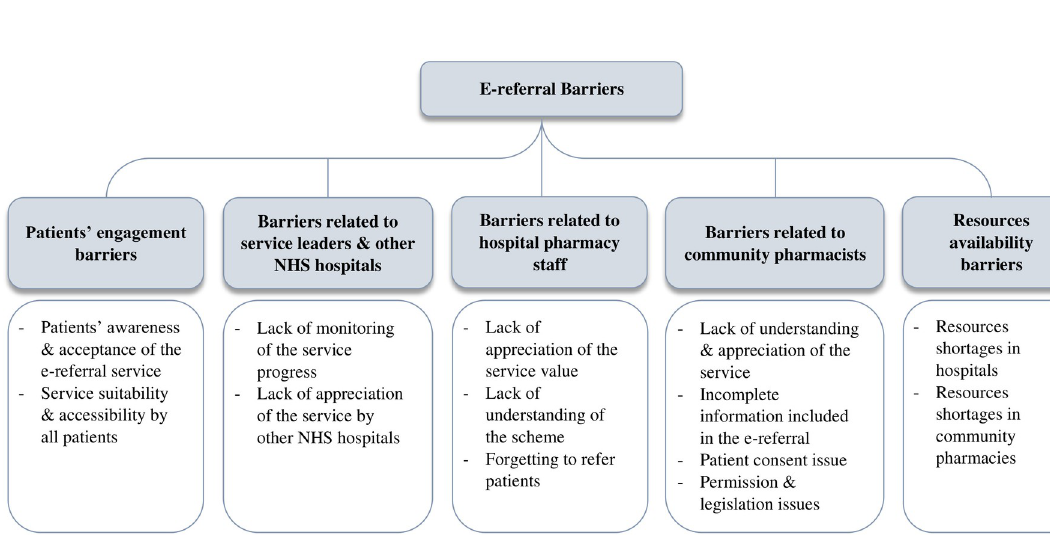
Fig 1. An overview of the barriers to the provision of the e-referral